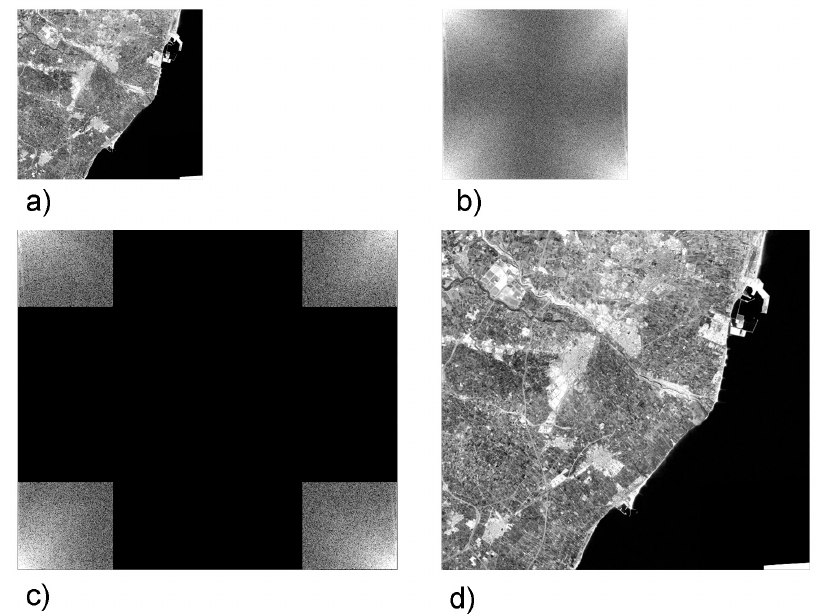
Figure 1. ( a ) Original image; ( b ) the Fourier spectrum of ( a ); ( c ) the Fourier spectrum embedded in a larger matrix; and ( d ) the inverse transform, representing an upsampled version of the original image.